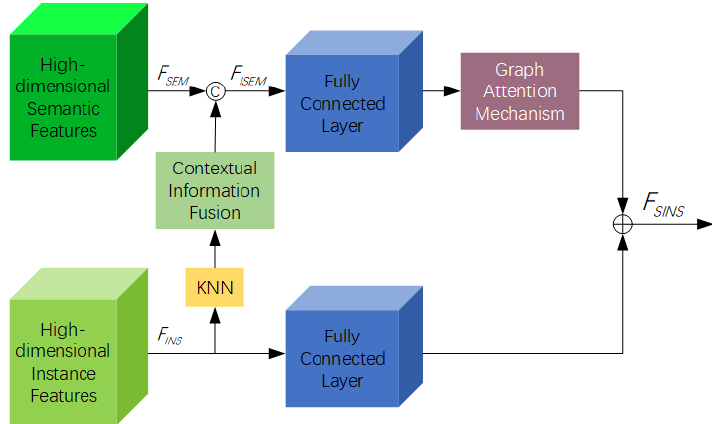
Figure 4. The illustration of feature fusion module.